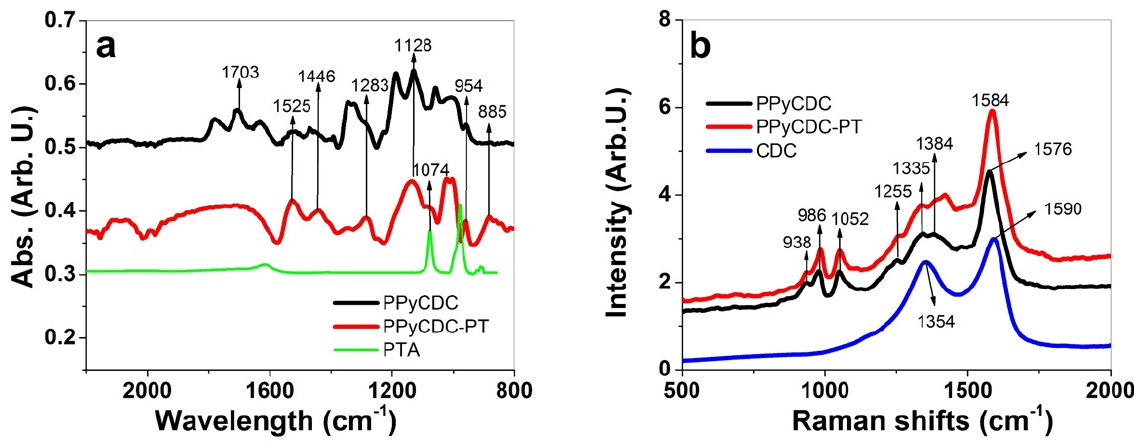
Figure 2. FTIR spectroscopy (2300 cm − 1 –800 cm − 1 ) of PPyCDC (black line), PPyCDC-PT (red line), and PTA (green line) are shown in ( a ). Raman spectroscopy (632.8 nm laser) between 2000cm − 1 – 500cm − 1 for PPyCDC (black line), PPyCDC-PT (red line), and pristine CDC (blue line) are displayed in ( b ).